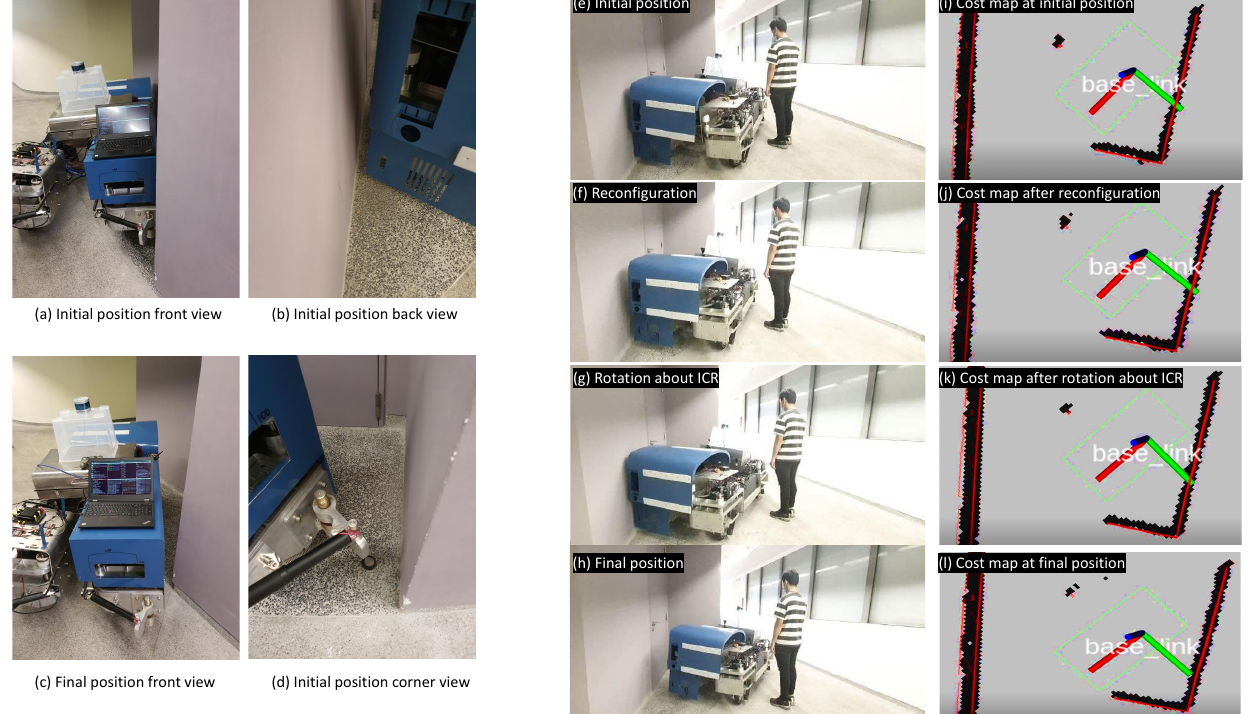
Figure 12. No rotation possible with fixed form robots depicting Scenario S4 (Figure